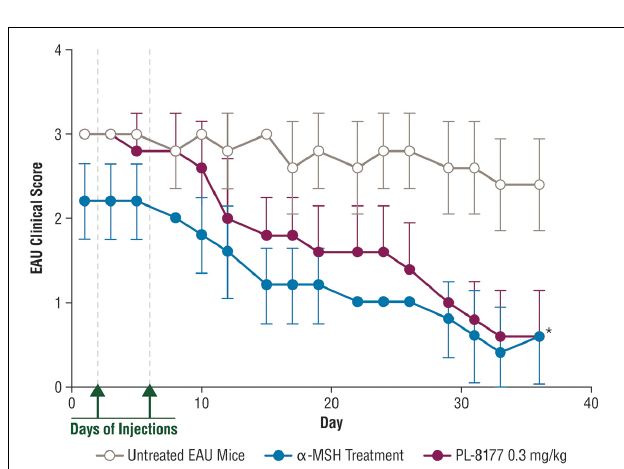
FIGURE 3 | Effect of PL-8177 treatment versus controls on inflammation scores of mice with induced experimental uveitis. ∗ P = 0.0001 by analysis of variance. α -MSH, alpha-melanocortin stimulating hormone; EAU, experimental autoimmune uveitis.